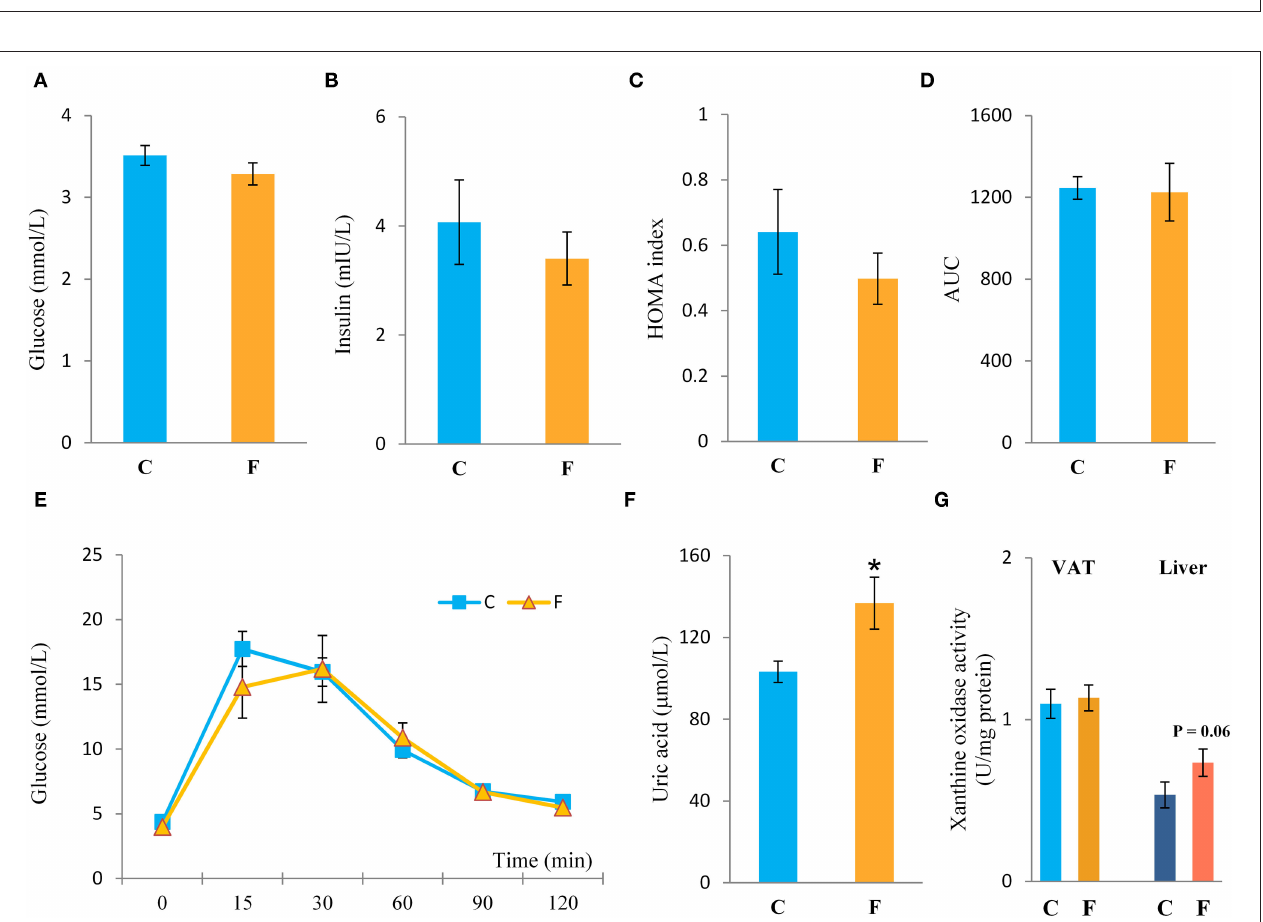
FIGURE 2 | adipocyte islets in the fructose-fed group, adipocyte (G) area and (H) diameter of control and fructose-fed groups, protein level of (I) PPAR γ , adipocyte (J) area and (K) diameter from islets of the fructose-fed group compared with homogenously distributed cells in the same group and (L) the percentage of small adipocyte islets area in total adipocytes area. Values for VAT mass, body mass, and Western blot represent the mean ± SEM ( n = 8 animals per group). For histology, three images were made per section, three sections per animal, and five animals per group. Statistical significance of between-group differences (Student’s t -test):